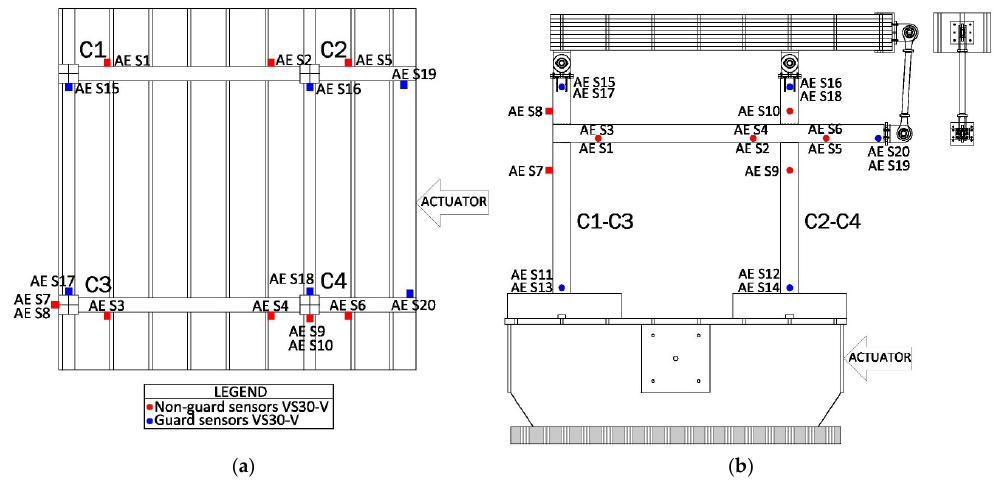
Figure 19 . RC frame with AE sensors (S1 to S20). ( a ) Plan (bottom view). ( b ) Elevation. Figure 19. RC frame with AE sensors (S1 to S20). ( a ) Plan (bottom view); ( b )